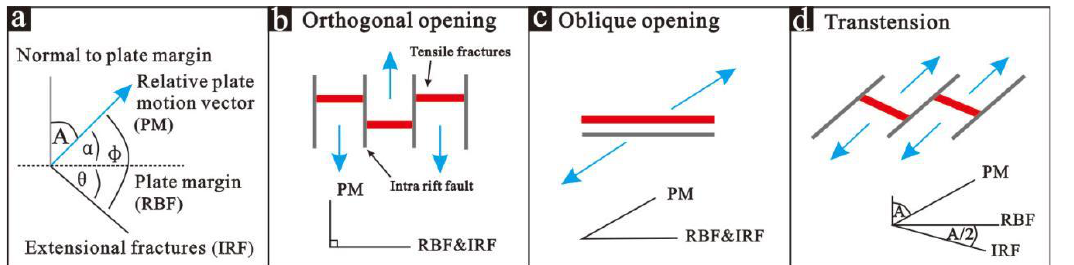
Figure 4. Models of extensional fault opening in rifts, modified from Tuckwell et al. [17]. θ = A/2 and φ = α/2 + 45°. ( a ) is the geometric relationship diagram of tectonic elements; ( b ) is orthogonal opening model of extension fractures; ( c ) is oblique opening model of extension fractures; ( d ) is transtension opening model of extension fractures.